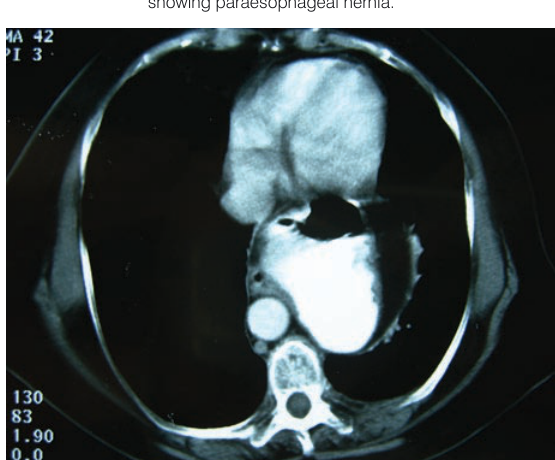
Figure 2. Abdominal Computed Tomography (CT) examination showing paraesophageal hernia.